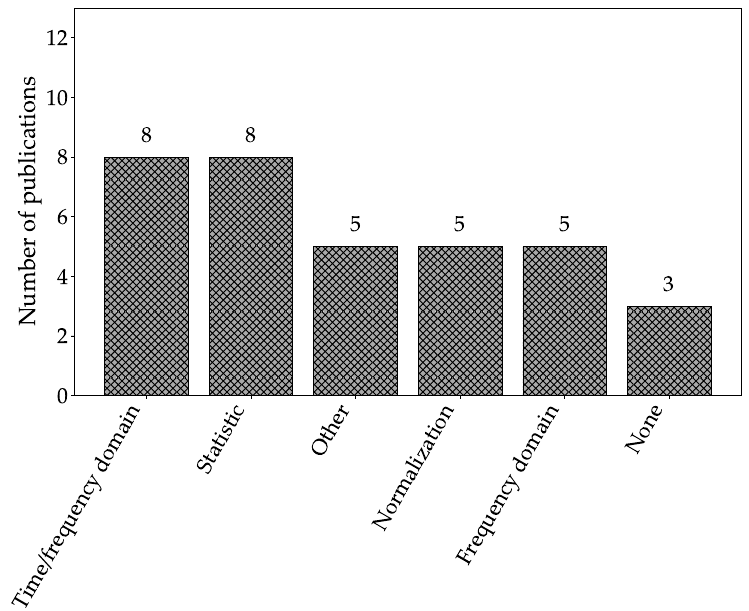
Figure 15. Repartition of SVM inputs.